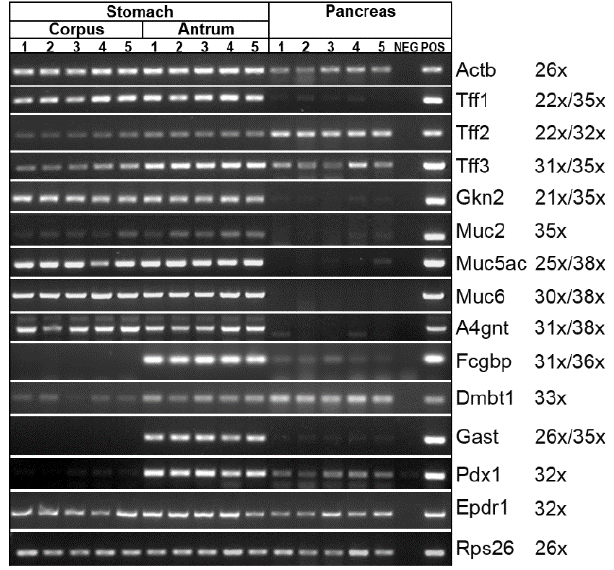
Figure 7. RT-PCR analysis. Tff1 , Tff2 , Tff3 , Gkn2 , Muc2 , Muc5ac , Muc6 , A4gnt , Fcgbp , Dmbt1 , Gast , Pdx1 , and Epdr1 expression in the gastric corpus and antrum, respectively, as well as in the pancreas. The number of amplification cycles is given in parentheses (if different for stomach and pancreas). As controls, expression of Actb and Rps26 , respectively, was monitored.